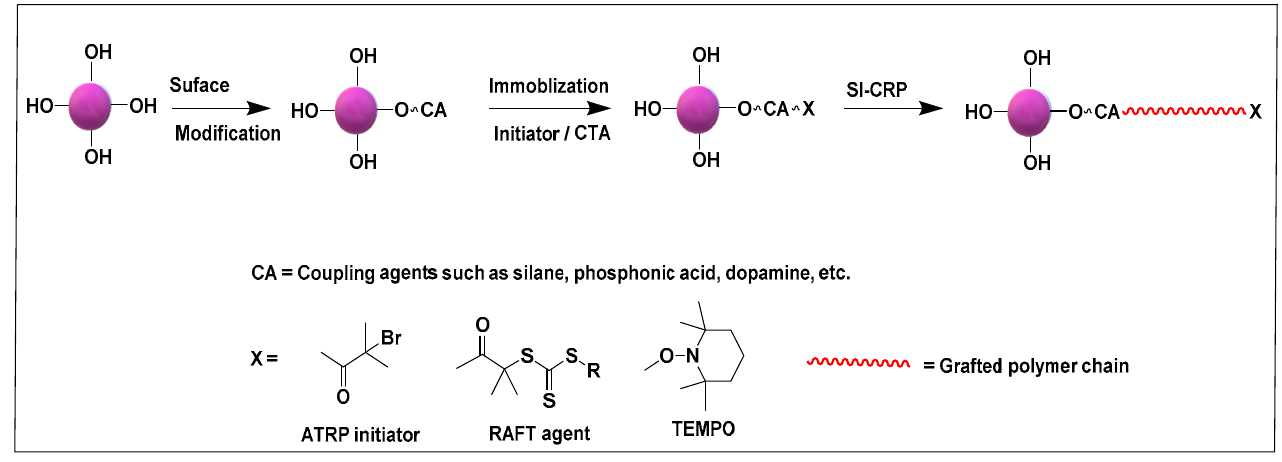
Figure 3. Scheme for surface initiated controlled radical polymerization methods. Table 2. Comparison of advantages and disadvantages of grafting from methods.